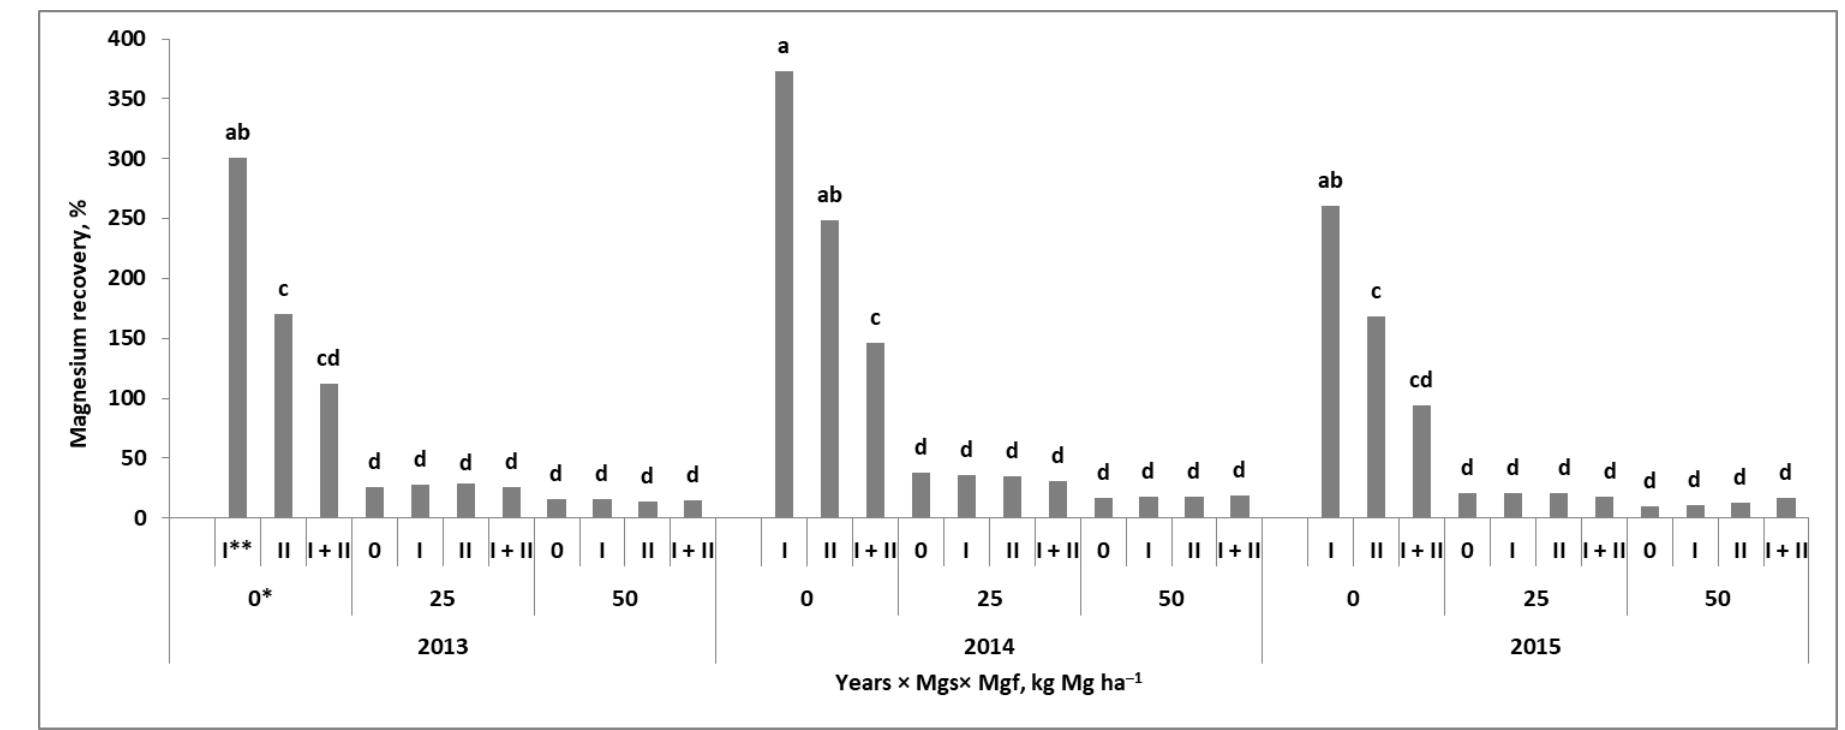
Figure A2. Magnesium recovery index in response to f Mg fertilization systems and years. a, b, c, d Similar letters mean a lack of significant differences using Tukey’s test . Legend: Mgs, Mgf — soil and foliar Mg fertilization system, respectively; *doses of applied Mg, kg ha ‒1 ; ** stages of Mg foliar fertilization to wheat: IBBCH — 30; II — BBCH 49/50.